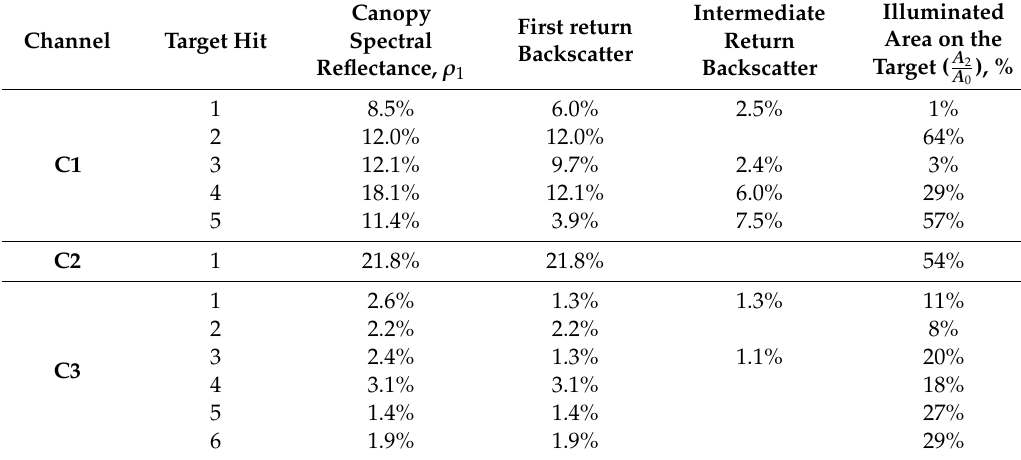
Table 8. Canopy spectral reflectance derived from below-canopy return responses and illuminated area on the below-canopy radiometric calibration target as a percentage of the footprint area at